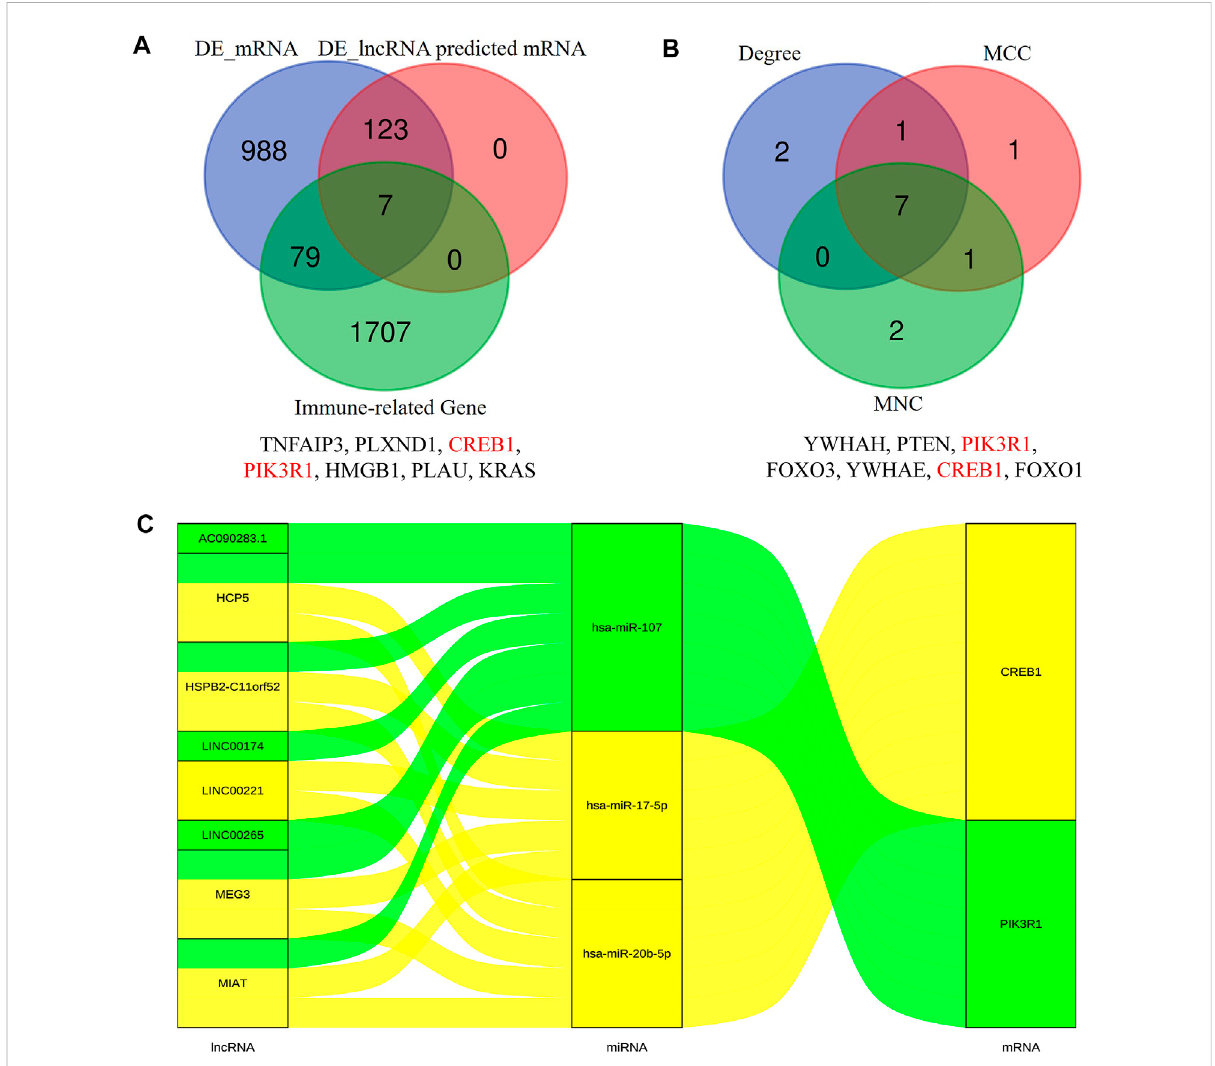
FIGURE 3 Identi fi cation of lncRNA-related DE-mRNAs (A) and hub genes (B) . The details of intersection in the Venn diagram are listed as follows. Constructionoftheimmune-relatedcoreceRNAnetworkinPAOD (C) .MCC,maximalcliquecentrality;MNC,maximumneighborhoodcomponent.